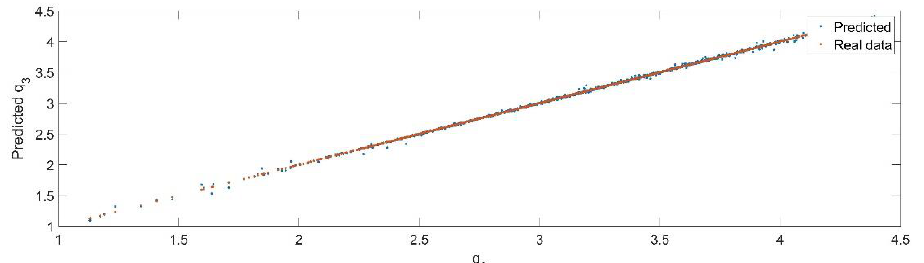
Figure 15. Convergence of the neural network for the first generalized coordinate 𝑞 3 (log scale).